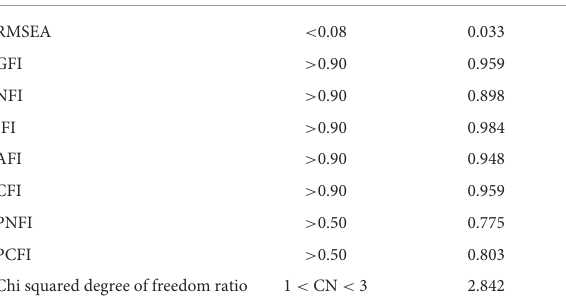
TABLE 7 Model suitability test table.